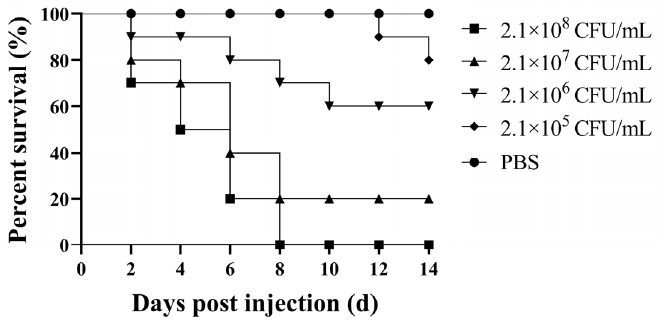
Figure 1. The survival rates of largemouth bass challenged by GJL1.